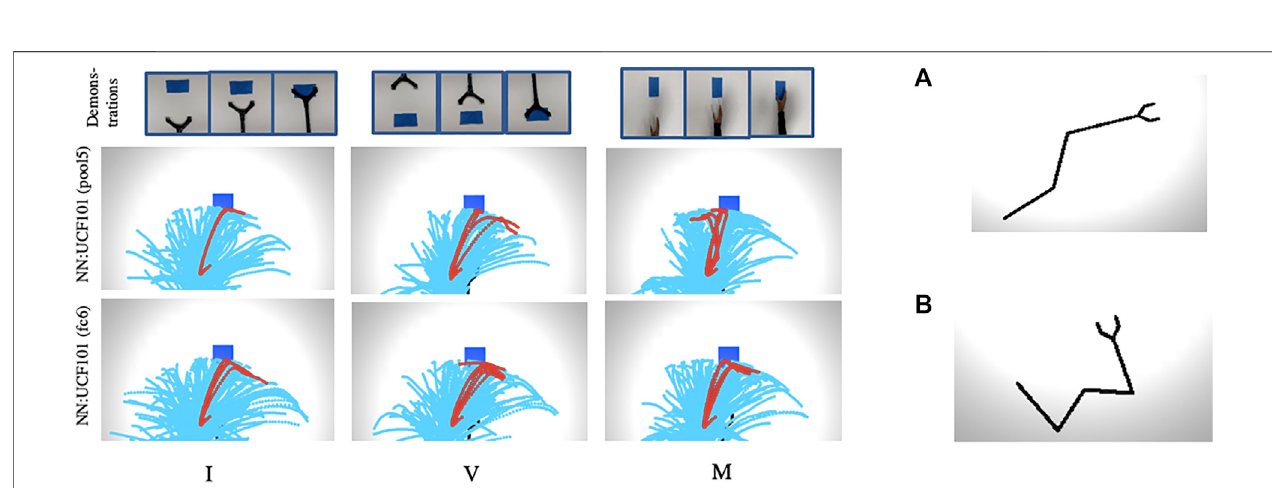
FIGURE 7 | (Left side) Trajectory maps for O 2 A (with NN:UCF101 model) obtained for the task of reaching with domain shifts: I,V and M when a manipulator with 4DOF is used. High rewards are obtained for desired trajectories for all the cases indicating that our method can work with manipulators of different DOF. (Right side) Manipulators used in the simulation experiment with (A) 3DOF and (B) 4DOF.